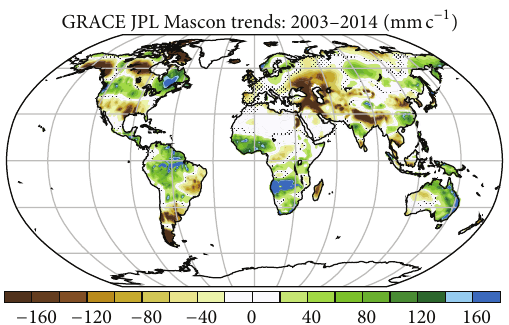
Figure 2: GRACE-era trends (2003–2014) in surface liquid water equivalent (mmc −1 ) from JPL Mascon fields [9], stippled where the signofthetrendisinconsistentacrossavailableGRACEdatasets(see